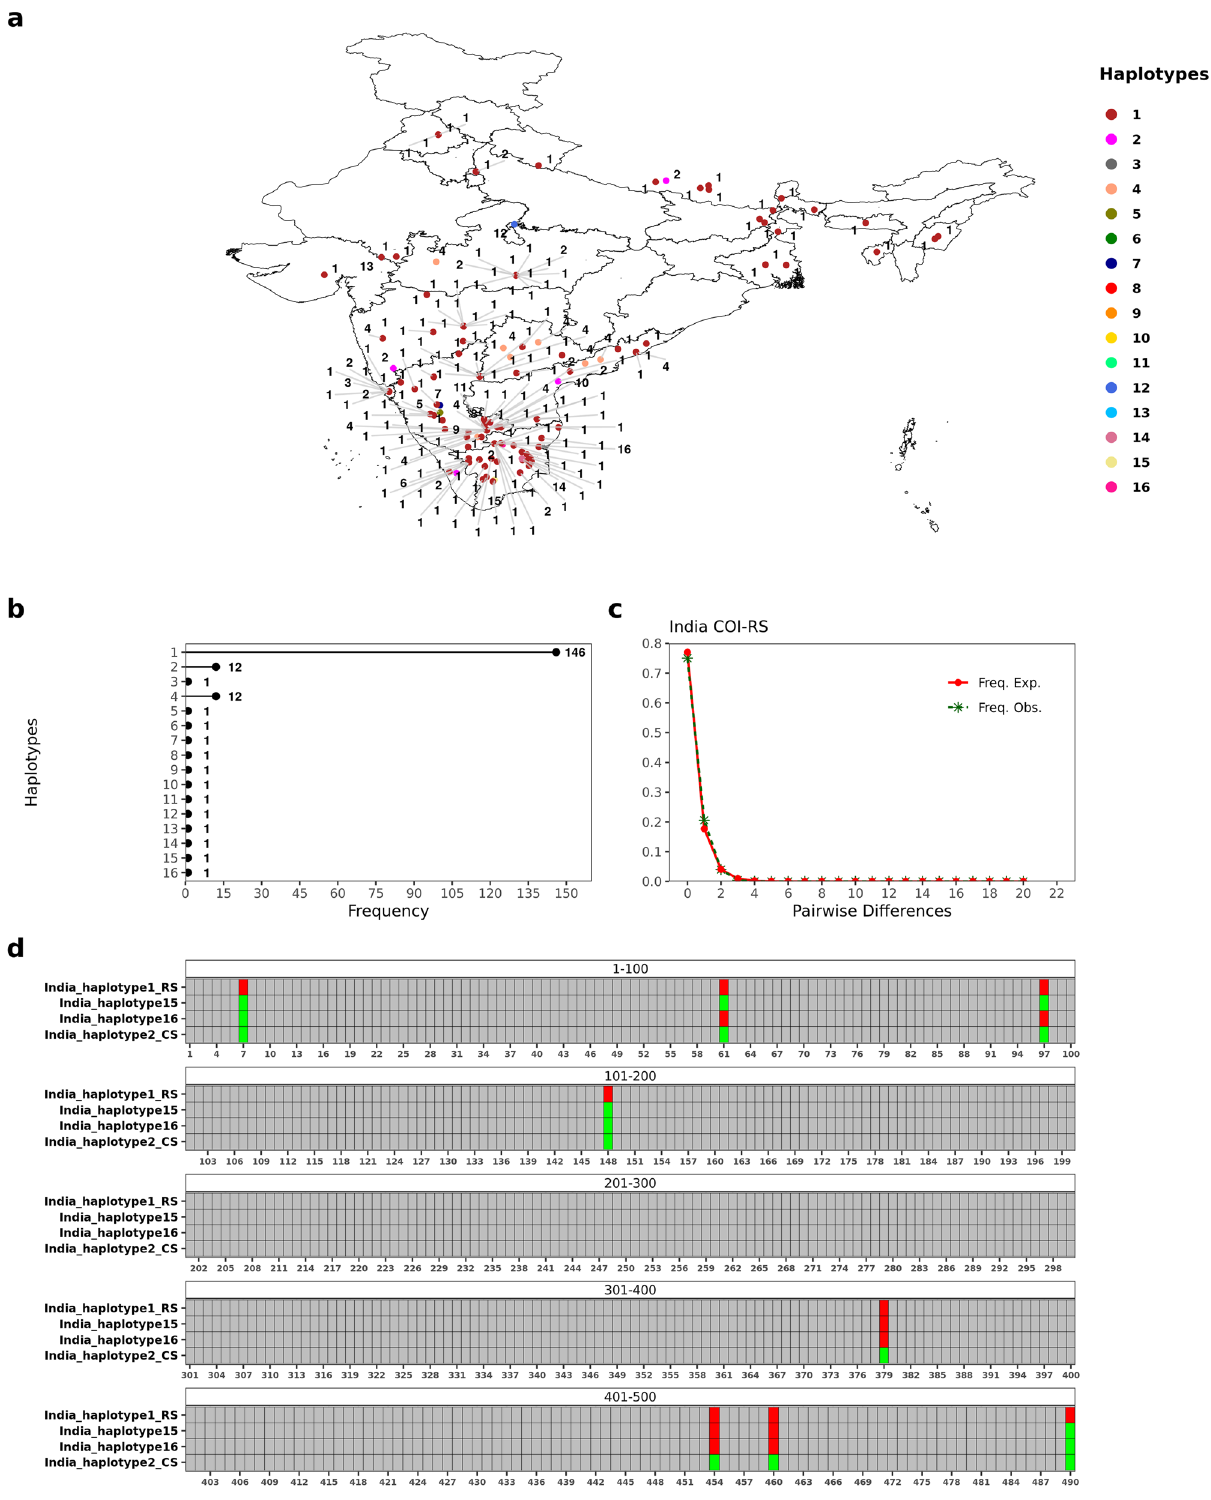
Figure 3. FAW COIA haplotypes from India. ( a ) Distribution of 16 different FAW haplotypes across India. ( b ) Frequency of the different haplotypes found in India. ( c ) Mismatch distribution curve for COIA rice strain haplotypes in India. ( d ) Depiction of polymorphisms in India_haplotype 15 and 16 within 490 bp region of mtCOIA gene with respect to Rice strain (RS) haplotype and a Corn strain (CS) haplotype. India_haplotype 15 and 16 showed characters typical of an inter-strain hybrid haplotype. The figure was drawn using R package tidyverse v 1.3.0 and patchwork v 1.1.1 24,26